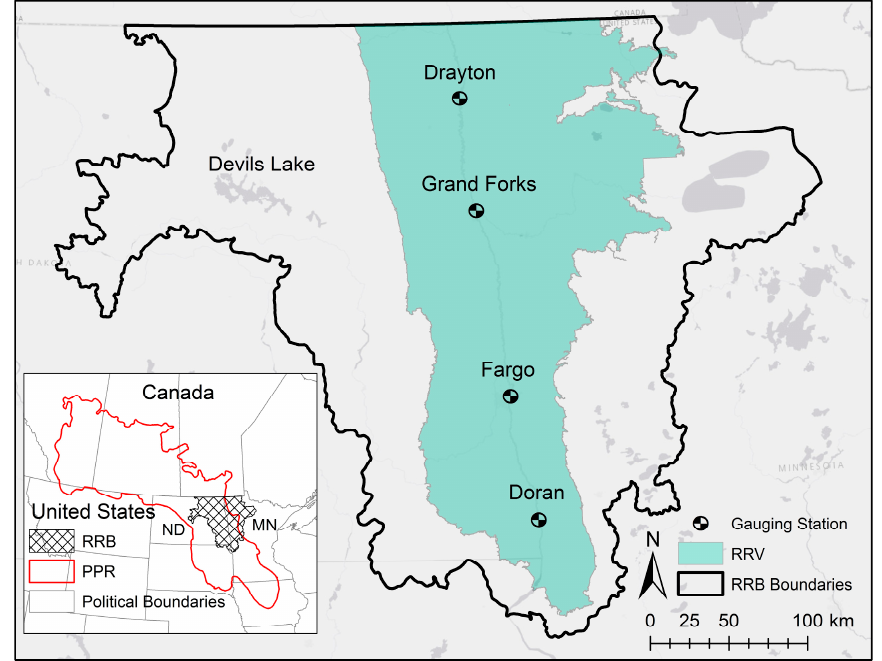
Figure 1. Prairie Pothole Region (PPR), Red River of the North Basin (RRB), Red River Valley (RRV), and four gauging stations in Doran, Fargo, Grand Forks, and Drayton. The slopes of the RRB range from 0.04 to 0.25 m/km [28]. Specifically, the central part of RRB (i.e., the Red River Valley (RRV)), which used to be the bottom of glacial Lake Agassiz, possesses a flat topography. The soil type, also affected by the bottom of former glacial Lake Agassiz, is mainly